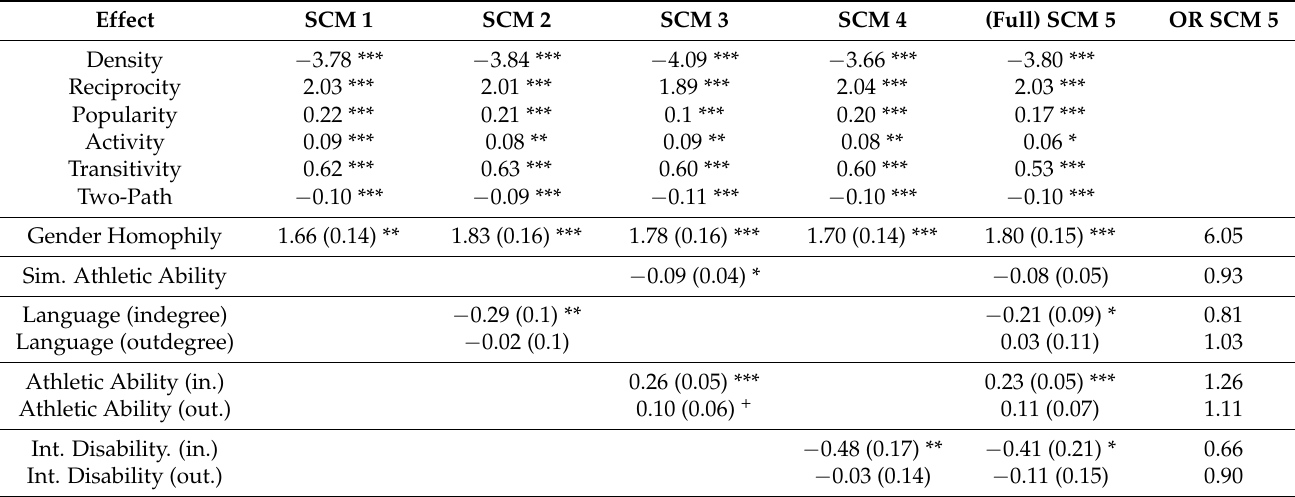
Table 5. Random-effects models for friendship networks in school.